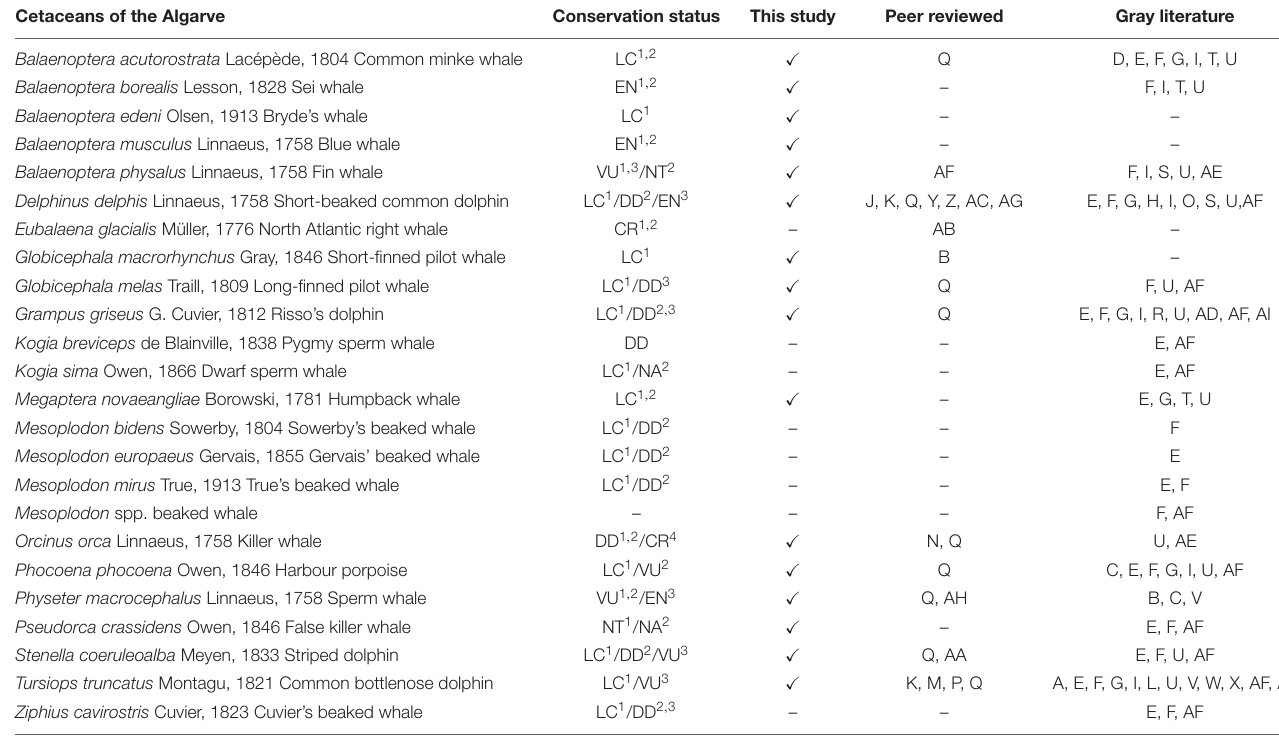
TABLE 2 | List of the 24 cetacean species that have ever been registered in the Algarve. Cetaceans of the